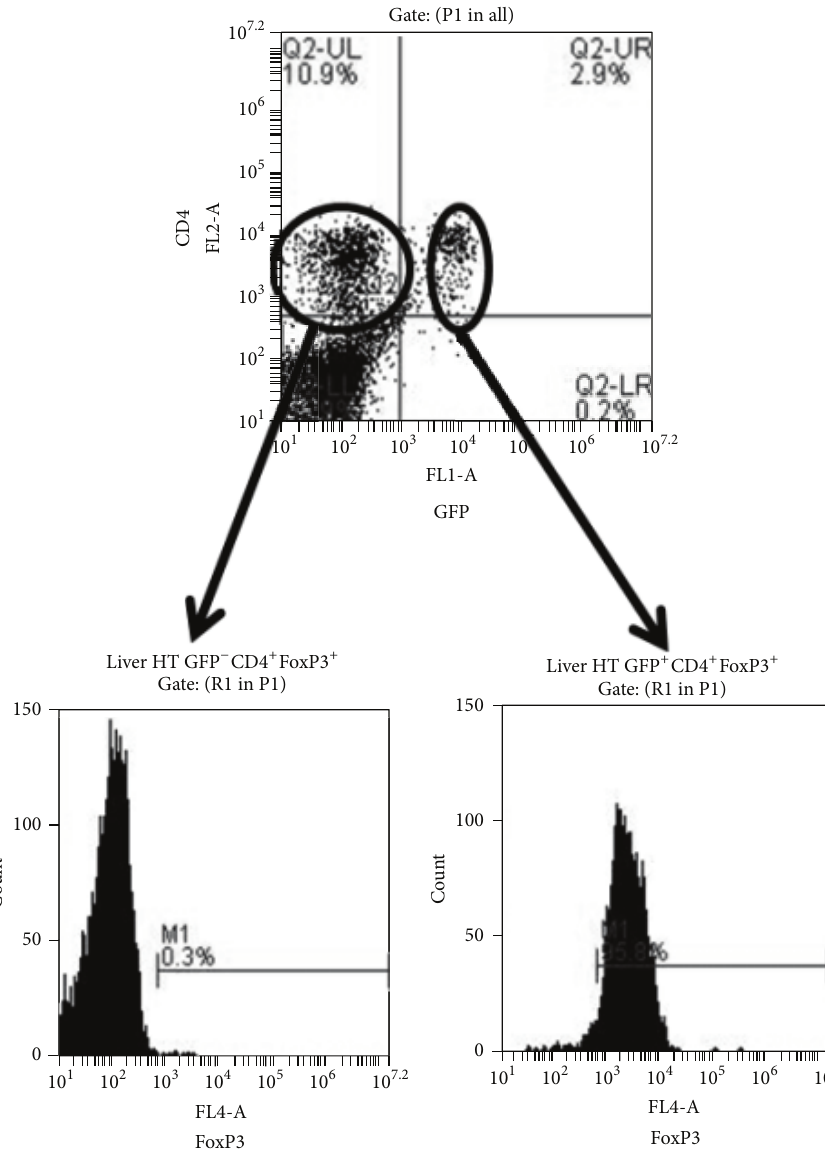
Figure 1: GFP expression is a reliable marker of FoxP3 expression in liver CD4 + cells from FoxP 3 EGFP transgenic reporter mice. NPC were isolated from liver of adult BALB/c-background FoxP 3 EGFP mice and CD4 + cells were sorted by GFP expression. Sorted cell populations were then analyzed by intracellular staining for FoxP3